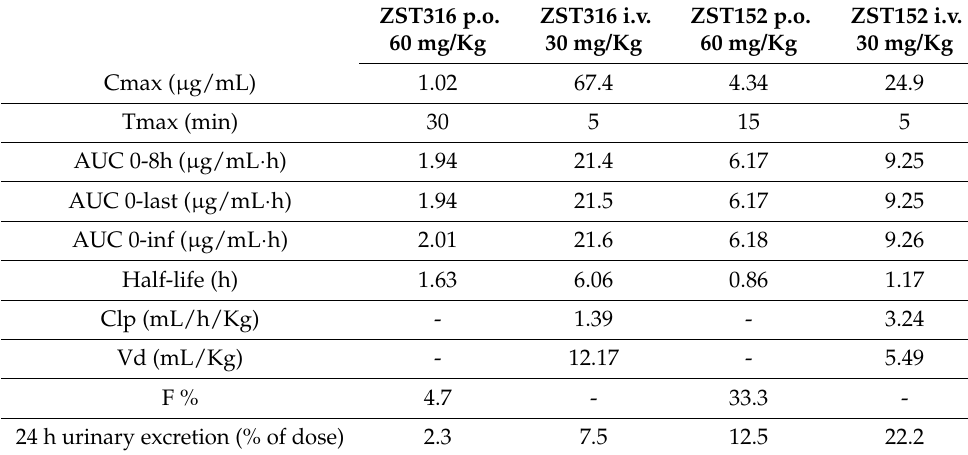
Table 6. Pharmacokinetic parameters and urinary elimination of ZST316 and ZST152 after single oral and intravenous administration.